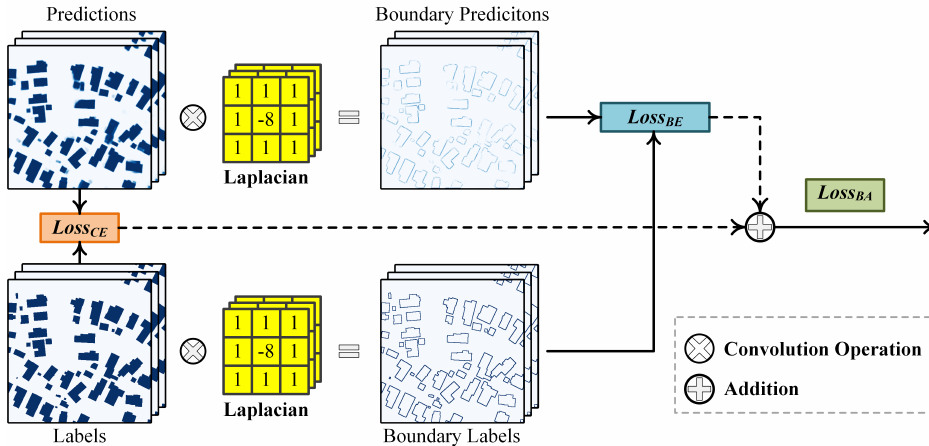
Figure 5. Principle of the proposed boundary-aware